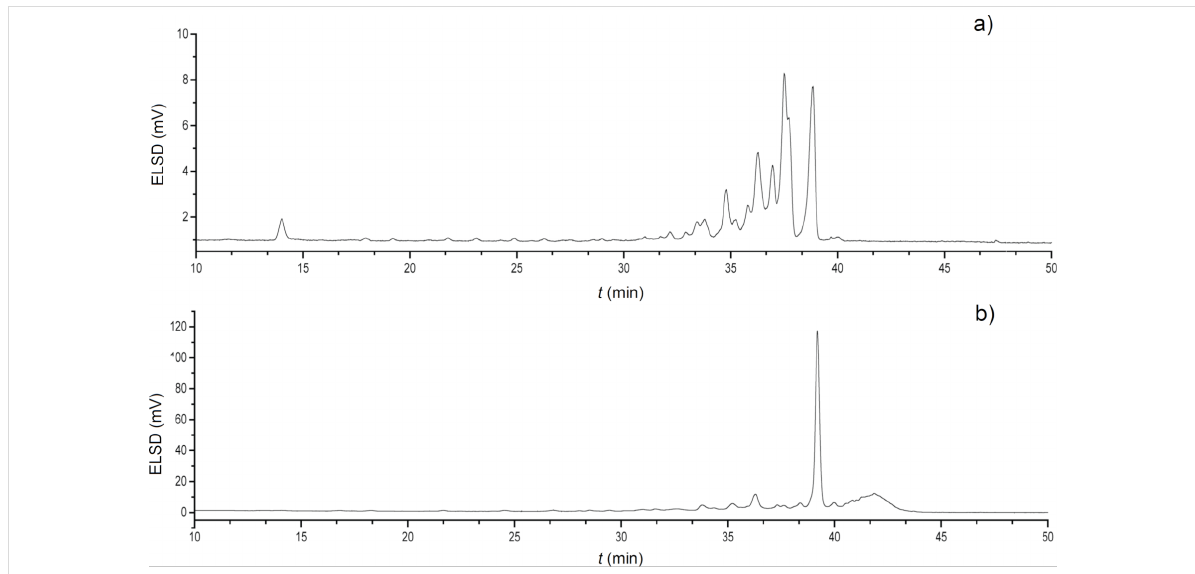
Figure 1: HPLC chromatograms of crude dodecamer 9 . a) Results obtained with AGA procedure A. b) Results obtained with AGA procedure B. For detailed procedures, see Tables S10 and S11 in Supporting Information File 1.